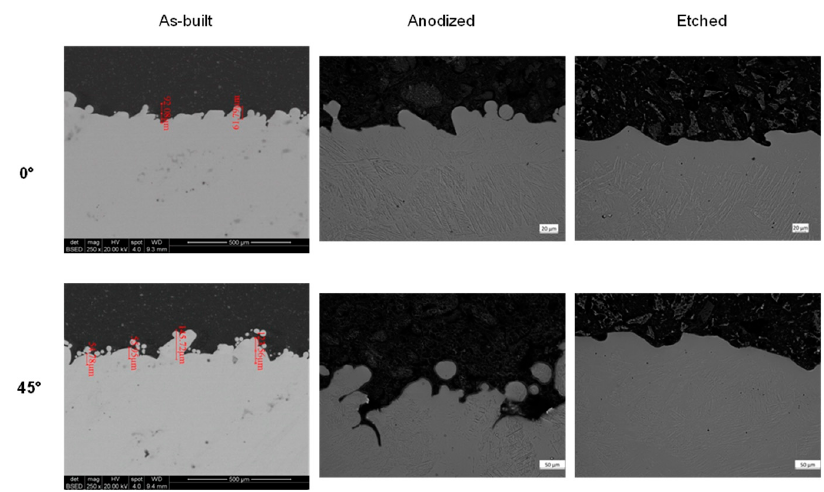
Figure 4. Micrographs illustrating the surface profile of the cross-sections of the samples built at different building angles and with different treatments.